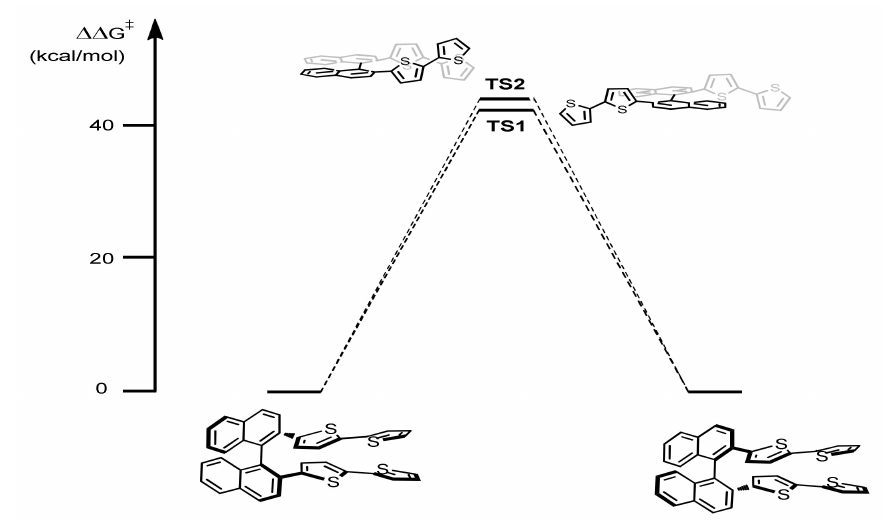
Figure 4. Reaction pathway for the racemization of Naph 2 T 4 . TS: transition state. ∆∆ G # is the di ff erence between the free Gibbs energy of the TS and the free Gibbs energy of the fundamental state.